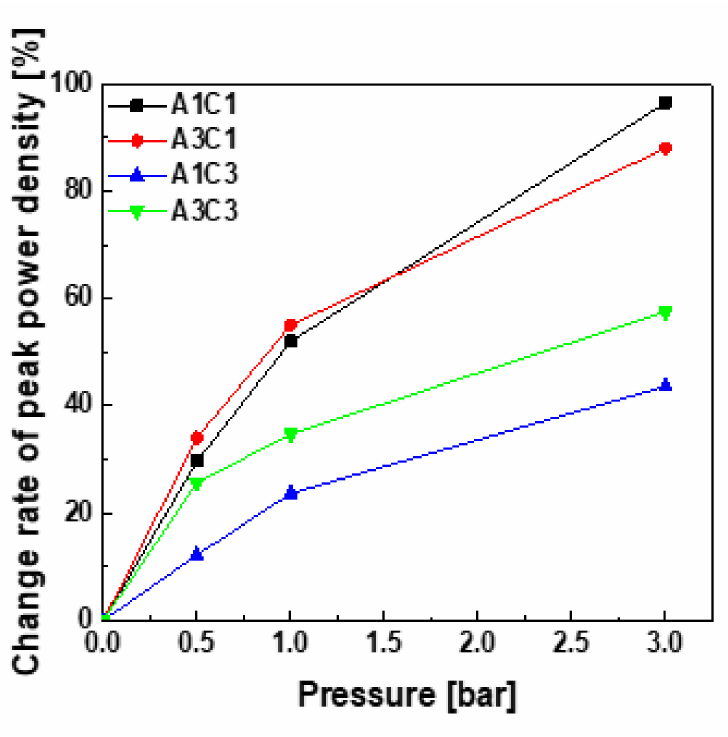
Figure 4. Change rate of peak power density by